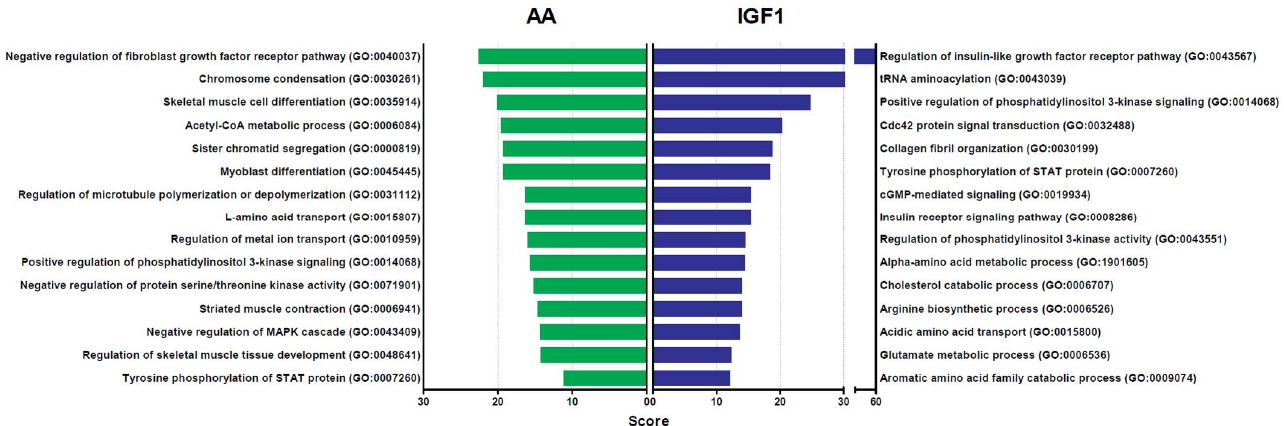
Figure 4. Gene ontology enrichment analysis of genes differently expressed in AA and IGF1 pacu- cultured myotubes. Biological processes were identified for up- and down-regulated genes in AA and IGF1 treatments compared to CTR group. Enrichment was defined as the 15 most significant terms according to the highest scores and p -values (<0.05).